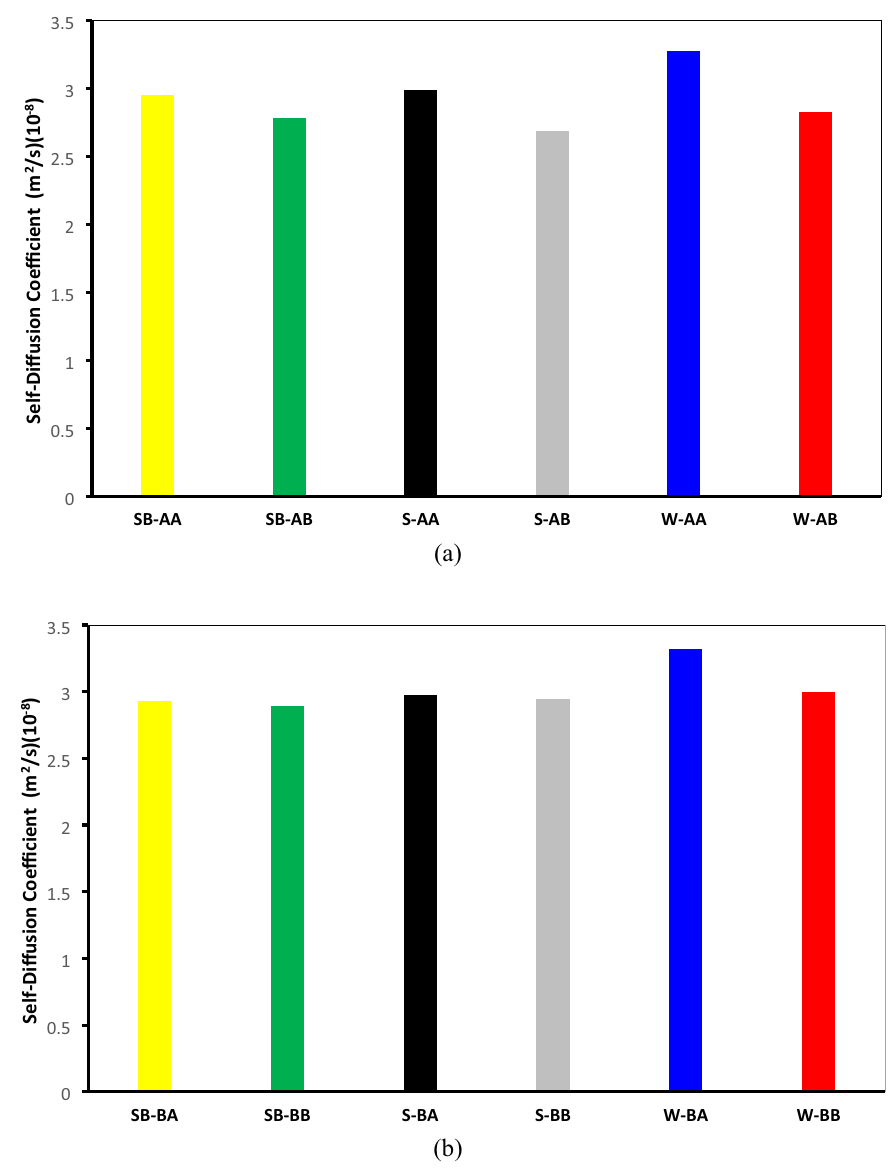
Figure 15. Self-diffusion coefficient of water at 498 K for systems containing ( a ) C 40 H 30 O 2 and ( b ) C 44 H 40 N 2